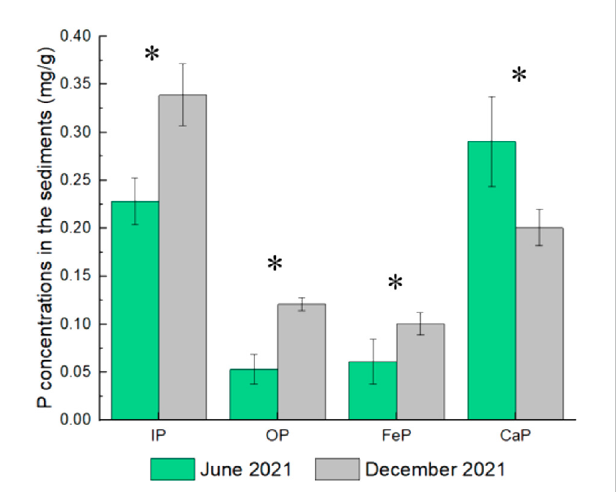
FIGURE 3 Concentrations of P forms in the sediments in the two periods (* represents signi fi cant differences of P forms concentrations in June 2021 and December 2021 (ANOVA, p <